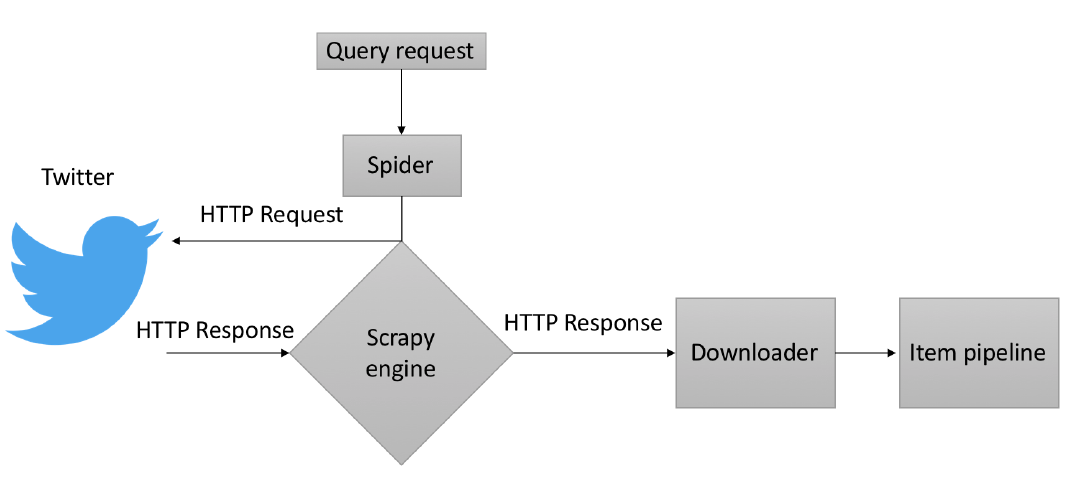
Figure 2. Data gathering